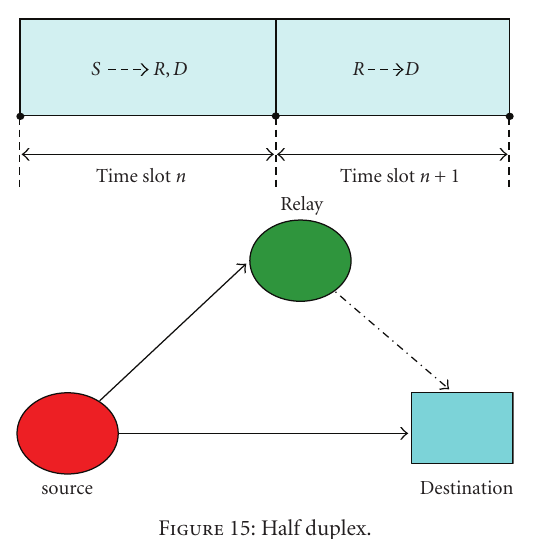
Figure 15: Half duplex.